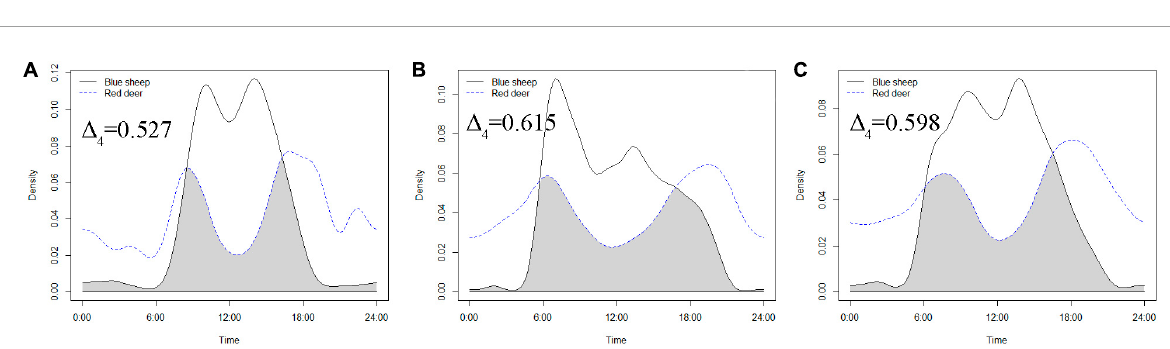
FIGURE3 Activity rhythms of blue sheep and red deer in camera traps that captured both species [ (A) = activity rhythms of blue sheep and red deer in cameras deployed in 2014, (B) activity rhythms of blue sheep and red deer in cameras deployed in 2015, and (C) activity rhythms of blue sheep and red deer in cameras deployed in 2014 and